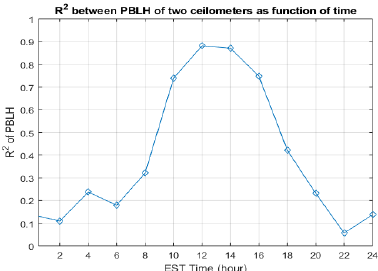
Figure 2. PBLH comparisons between CHM15k and CL51